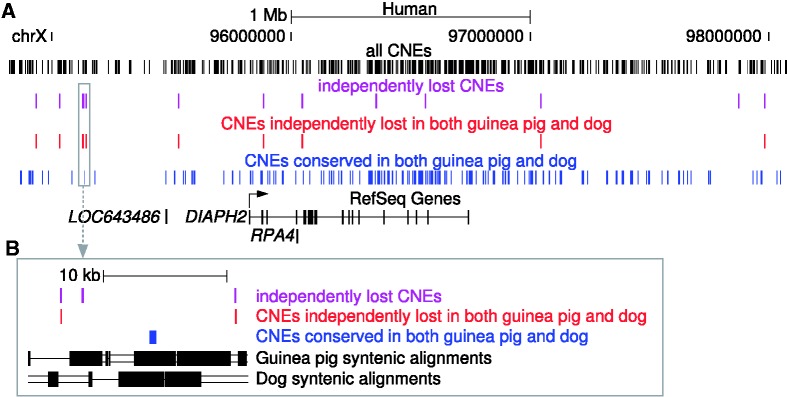
Many independent CNE losses around the DIAPH2 gene in guinea pig and dog. (A) The DIAPH2 locus contains the largest concentration of independent CNE loss events with 13 losses within 5 Mb. Note that each pair of CNEs that are independently lost in guinea pig and dog (red) is separated by at least one CNE that is conserved in guinea pig and dog (blue), which shows that all nine CNEs are lost by independent events (as opposed to being lost by a small number of large loss events that remove several CNEs at once). None of these 13 CNEs show any evidence for transcription. DIAPH2 is likely a functional gene in both guinea pig and dog. Other genes in this locus are the non-coding RNA gene LOC643486 and the coding gene RPA4 (replication protein A4, 30 kDa). RPA4 is likely a primate-specific gene, while the CNEs all have at least placental mammal ancestry. (B) Zoom-in of the grey-boxed region in (A) illustrates how the presence of a CNE conserved in guinea pig and dog (blue) shows that the two CNEs independently lost in guinea pig and dog (red) are lost by two separate events in guinea pig and dog. The representation of pairwise alignments is as in Figure 2A.